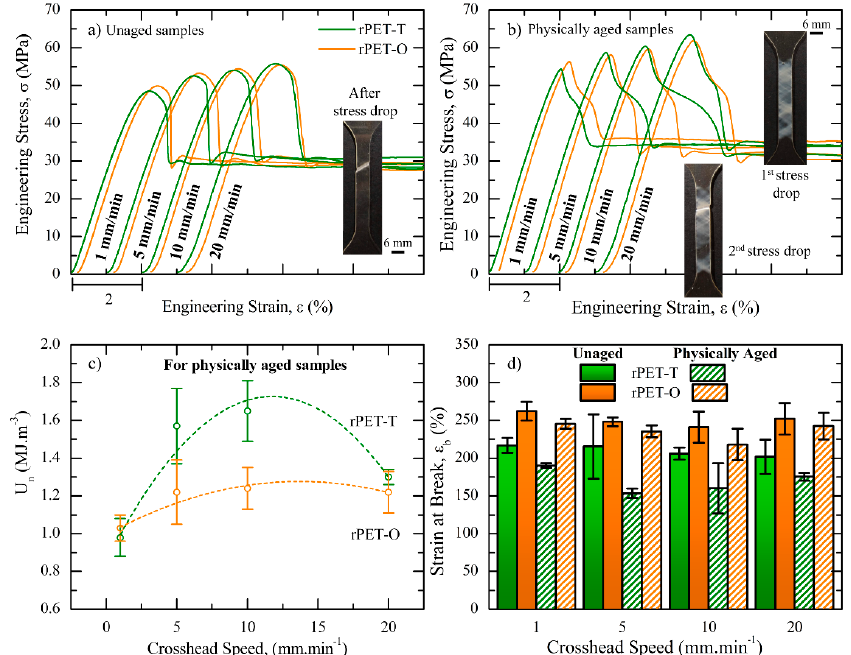
Figure 5. Effect of the crosshead speed on the mechanical properties of unaged and physically aged rPET-T and rPET-O: ( a , b ) engineering stress–strain curves; ( c ) strain energy density value up to the onset of necking versus crosshead speed, and ( d ) strain at break values versus crosshead speed. Table 4. Uniaxial tensile properties at different crosshead speed. For information purposes, T and O referred to as rPET-T and rPET-O materials, respectively. P.A. referred to as physically aged samples. Property